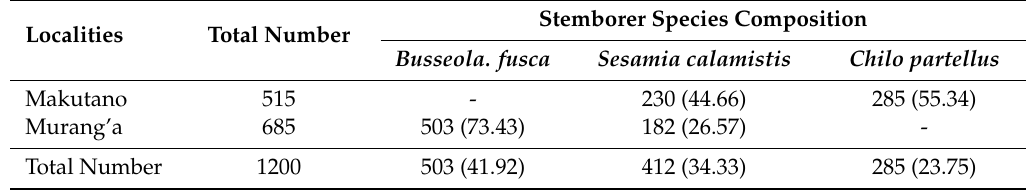
Table 6. Total number of larvae / pupae of lepidopteran maize stemborer species (with the relative proportion (%) in parenthesis) collected in maize plants in cultivated fields during the subsequent cropping seasons in two di ff erent localities in the central region of Kenya in 2017 and 2018.